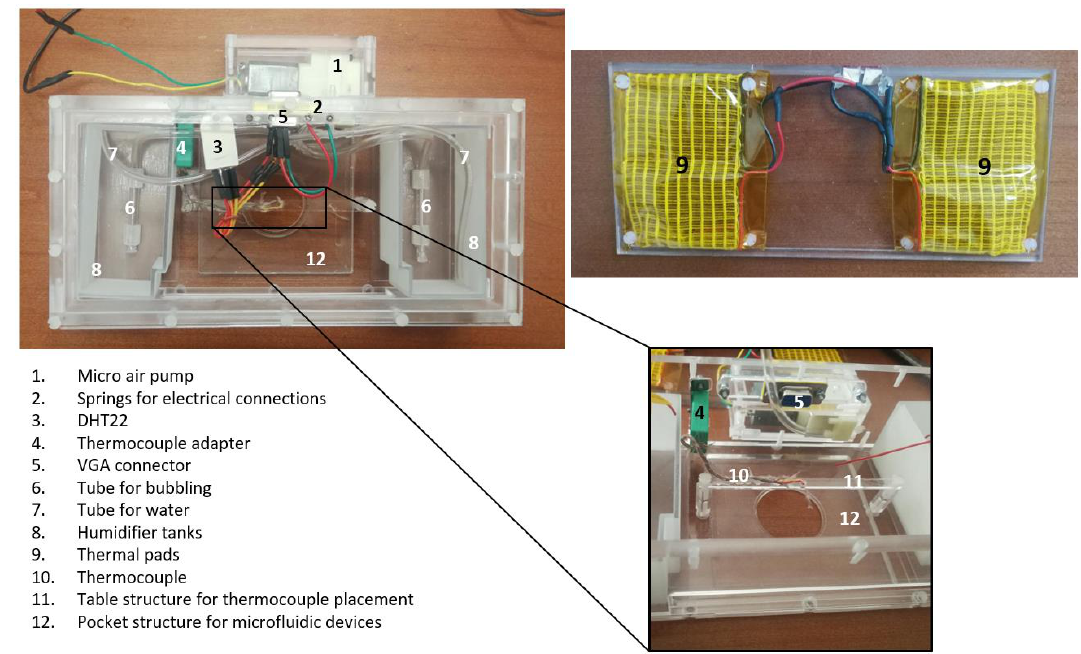
Figure 2. The mini-incubator used to characterize and validate the microfluidic device. Its dimensions make it possible to couple such a mini-incubator to an inverted microscope stage.